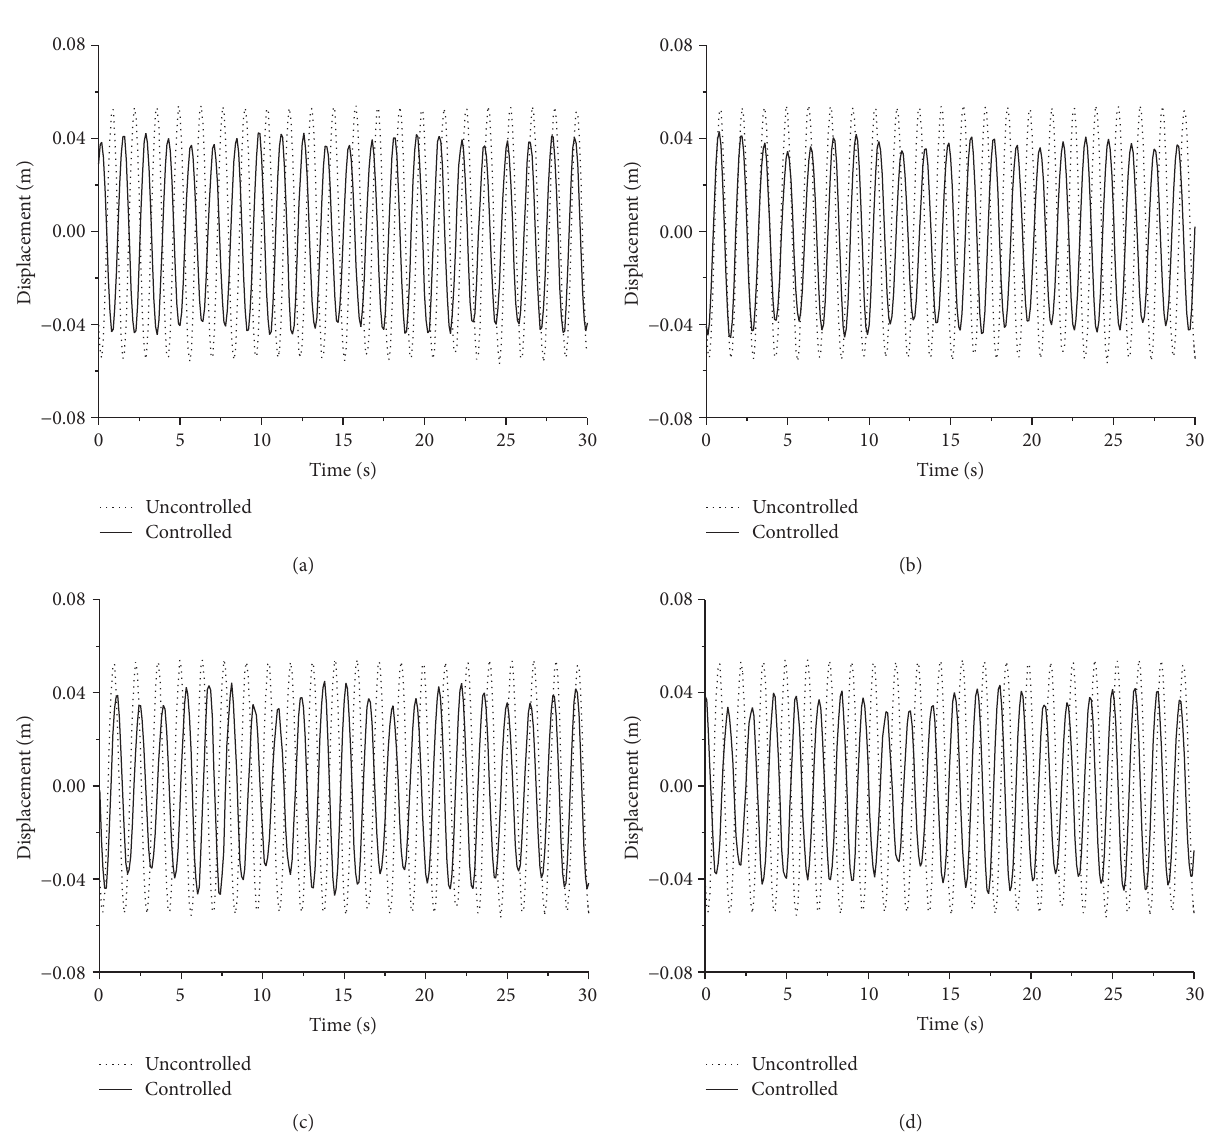
Figure 8: Comparison of displacement responses to 4th floor of the experimental system. (a) 4-order model, (b) 6-order model, (c) 8-order model, and (d) full-order model.